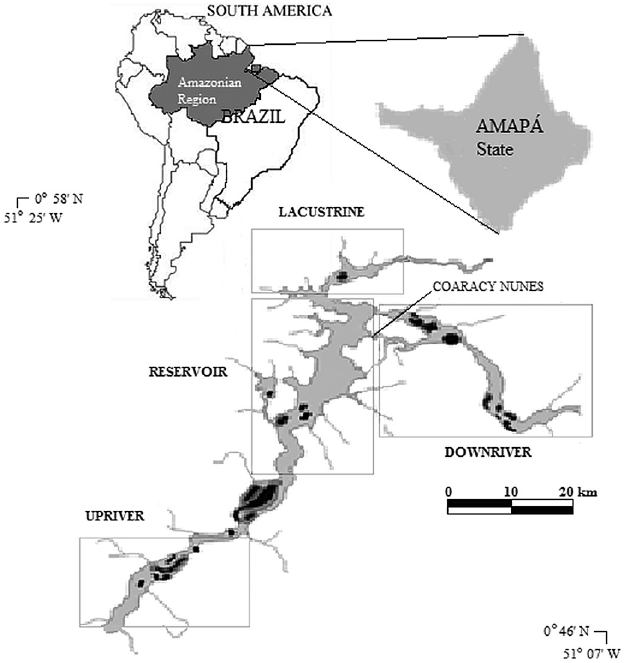
Figure 1 - Study region localization of Coaracy Nunes Reservoir. Samplings were made in distinct areas: Downriver, Reservoir, Lacustrine and Upriver (State of Amapá -